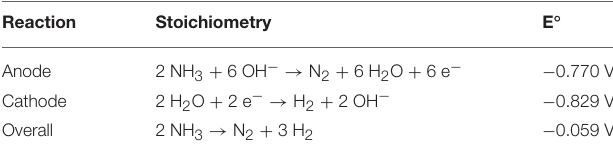
TABLE 2 | Electrochemical reactions for the ammonia electrolysis process.